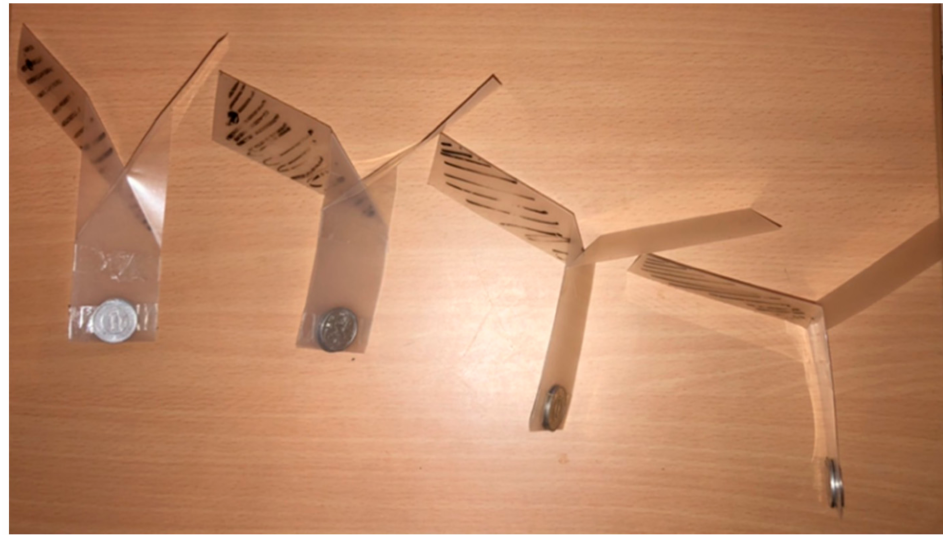
Figure 11. Model used in the